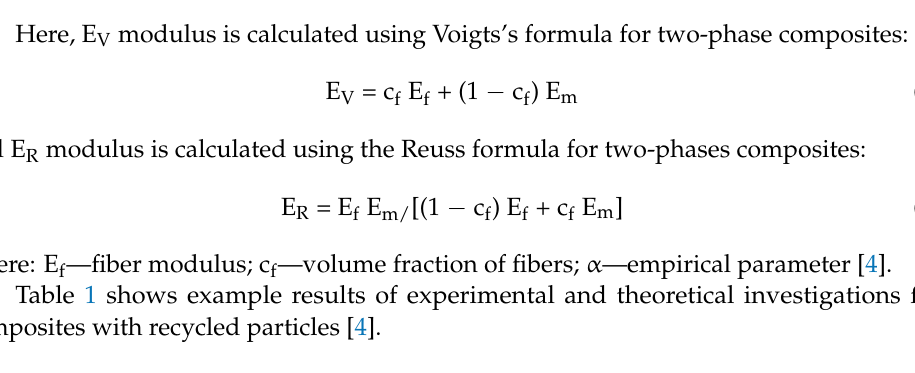
Table 1. Comparison of experimental and theoretical values of modulus of composites with recycled particles